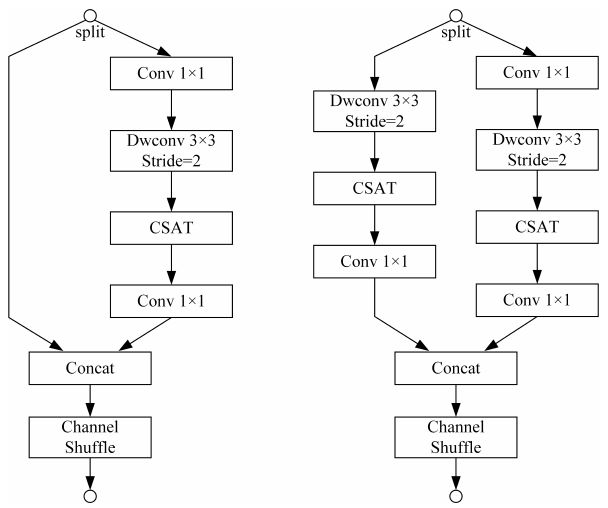
Figure 6. The structure of the CSAT insertion